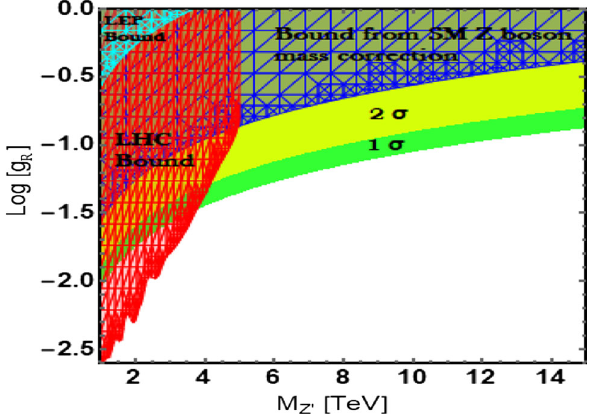
Fig. 16 Current existing bounds and projected discovery reach at the ILC in M Z (cid:2) − g R plane. Green and yellow shaded zones correspond to sensitivity confidence levels 1 σ and 2 σ looking LR asymmetry for U ( 1 ) R extended model at the ILC. Red meshed zone in M Z (cid:2) − g R plane indicates the excluded region from the upper limit on the cross-section for the process pp → Z (cid:2) → l + l − at 95% C.L. using ATLAS results at √ s = 13 TeV with 36.1 fb − 1 integrated luminosity. The cyan meshed zone is excluded from the LEP constraint. The blue meshed zone is excluded from the limit on SM Z boson mass correction: 1 12 . 082